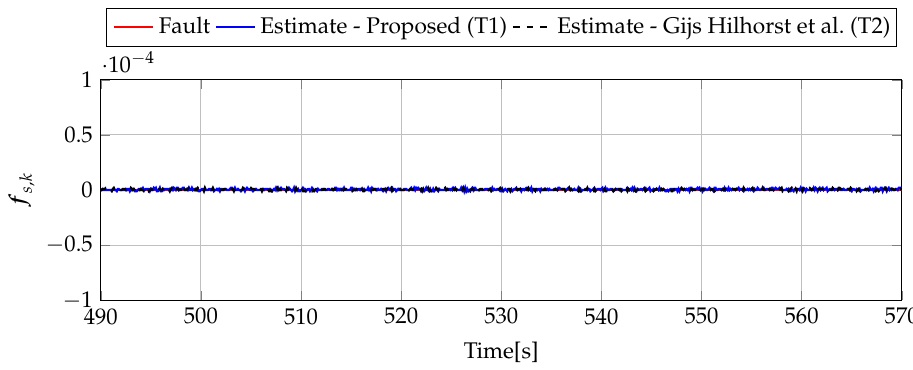
Figure 13. Actuator fault estimate for fault-free case (for t = 490, . . . ,570) with Theorem 1 (T1) and Theorem 2 (T2) based on [39] for disturbance signal w 1, k .